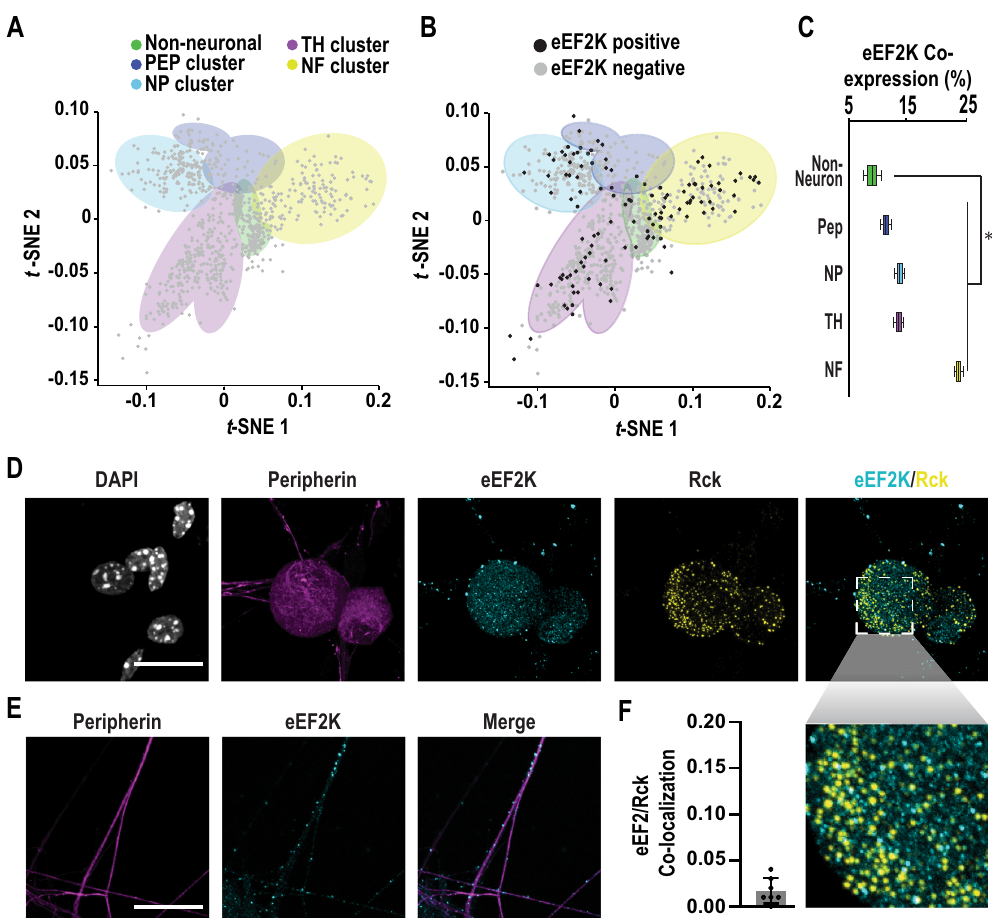
Fig. 3 eEF2K is expressed in sensory neurons but does not localize to SNPBs. A Single cell clusters based on expression of marker genes for the following populations of cells: non-neuronal ( Vim ), peptidergic ( Calca /CGRP), non-peptidergic ( Mrgprd ), tyrosine hydroxylase (Th), and a light chain neuro fi lament expressed in large diameter neurons ( Nefh ). Data were obtained from Usoskin and colleagues and subjected to unbiased clustering 75,76 . B eEF2K expression in individual cells within these clusters. C Quanti fi cation of co-expression of eEF2K with marker transcripts. Boxes display mean, fi rst, and third quartiles. Whiskers indicate minimum and maximum values. P value determined by Fisher ’ s exact test, one tailed, signi fi cance of 0.05. p = 0.0357. For non-neuronal, PEP, NP, TH, and NF clusters n = 88, 73, 141, 280, and 167 cells, respectively. For details on analysis, see Methods . D Untreated primary DRG cultures were used for ICC and imaged with confocal microscopy. Representative images of cells labeled for peripherin (magenta), eEF2K (cyan), and Rck (yellow). Nuclei were stained with DAPI (white). Scale bar = 20 µ m. E Axons of cells from D were also imaged. Representative confocal images show peripherin (magenta) and eEF2K (cyan) immuno fl uorescence signals within axons. Scale bar 20 µ m. F Mean colocalization of eEF2K and Rck immuno fl uorescence signals within peripherin-positive cell bodies using Pearson ’ s correlation coef fi cient (PCC), n = 7 cells. Mean Pearson ’ s = 0.017. Error bars indicate ±SD. Source data are provided as a Source Data fi